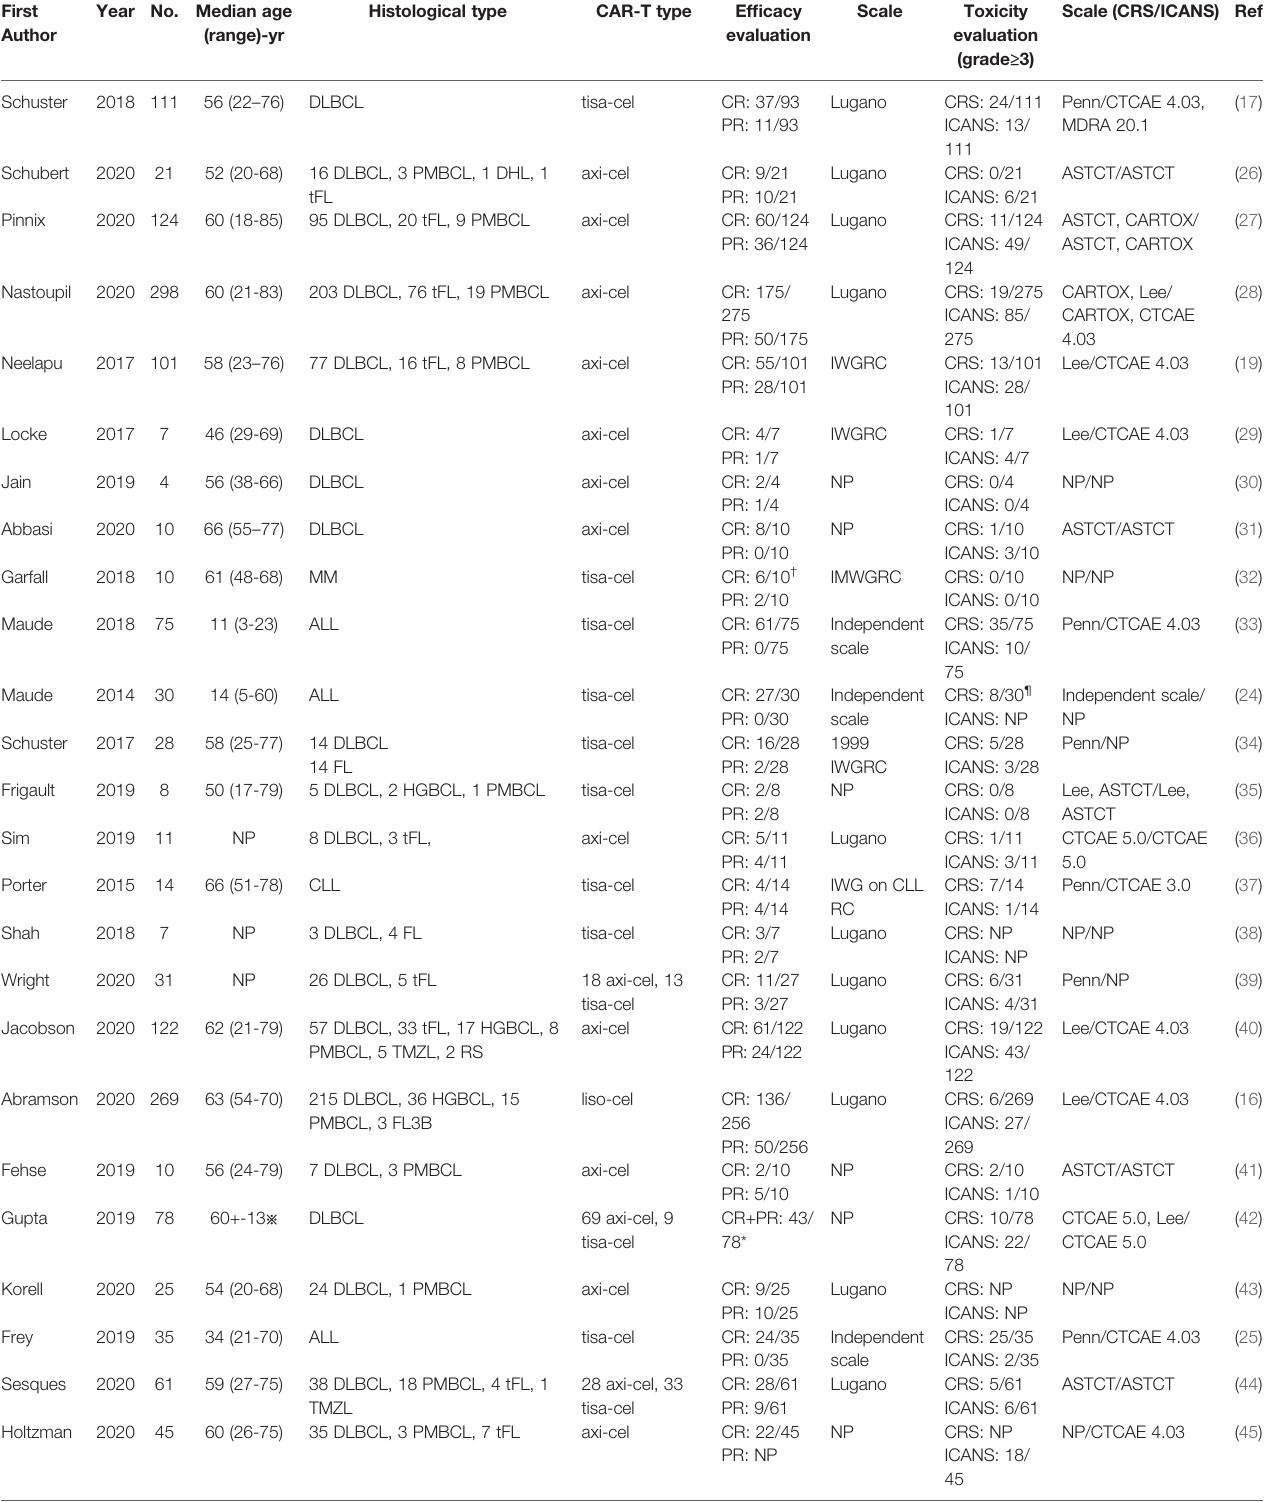
TABLE 2 | Characteristics of included